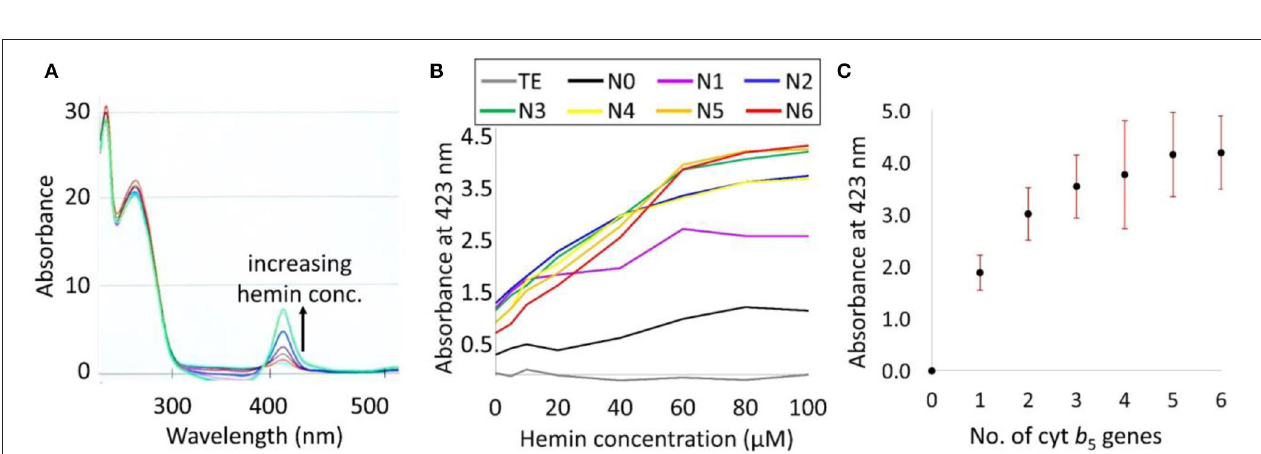
Figure 5B identifies the saturation point of hemin to be at 60 µ M as any further increase in hemin concentration did not change the absorption value at 423 nm. Using the established optimum concentration of hemin (60 µ M), an increasing trend of Cyt b 5 content was detected and correlated directly with increasing gene copy numbers, as shown in Figure 5C